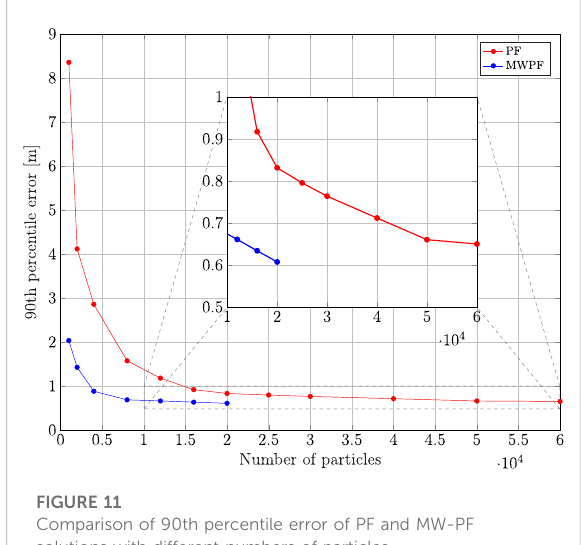
FIGURE 11 Comparison of 90th percentile error of PF and MW-PF solutions with different numbers of